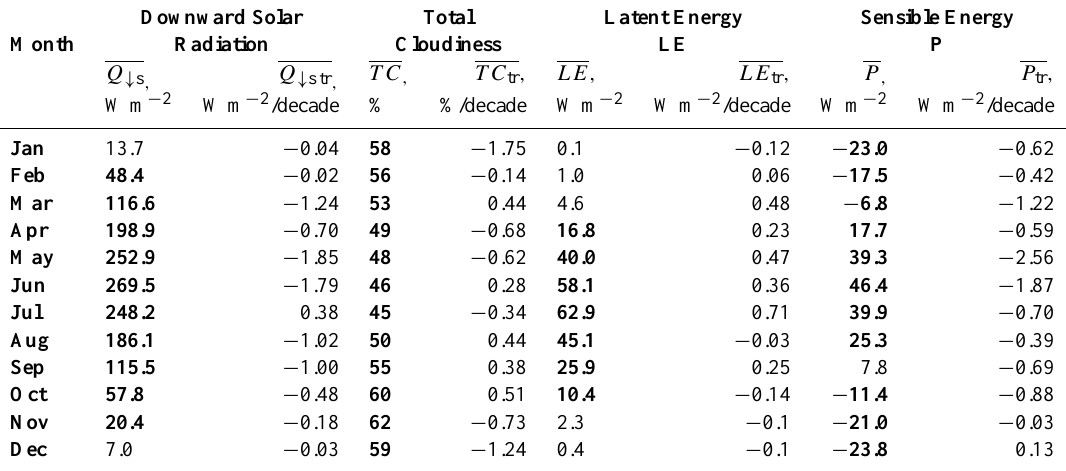
Table 3. Variability of monthly averaged values of TC, Q ↓ S , LE and P over ATR calculated by JRA-25 reanalysis for period 1979–2008. Statistically significant values are in